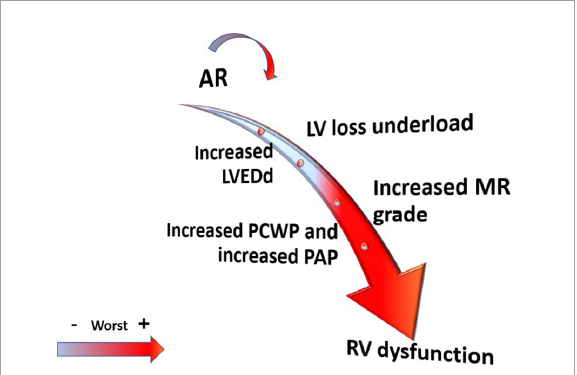
Different LVAD modalities and their effect on AV